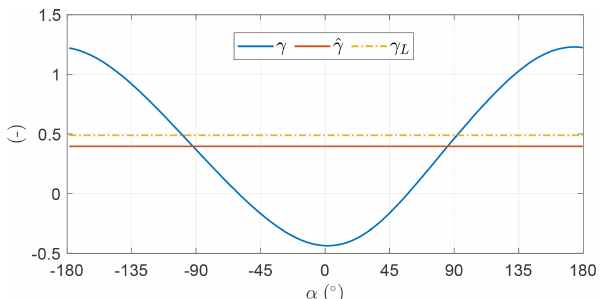
Figure 18. Optimal γ as a function of the angular